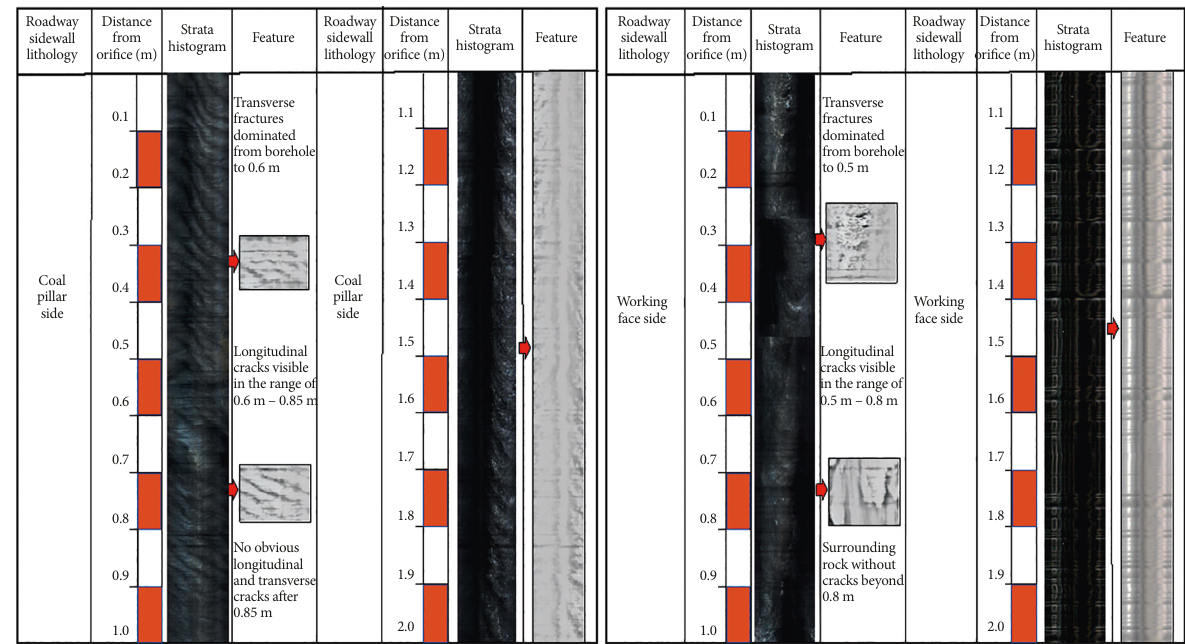
Figure 7: Loose ring development in the gang section of the